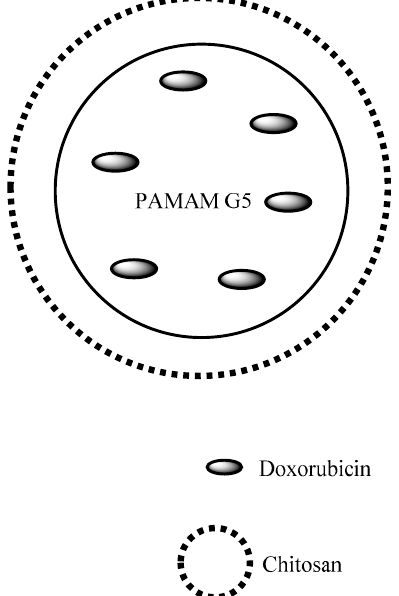
Figure 12. Nanocapsule of chitosan containing PAMAM G5 encapsulated DOX